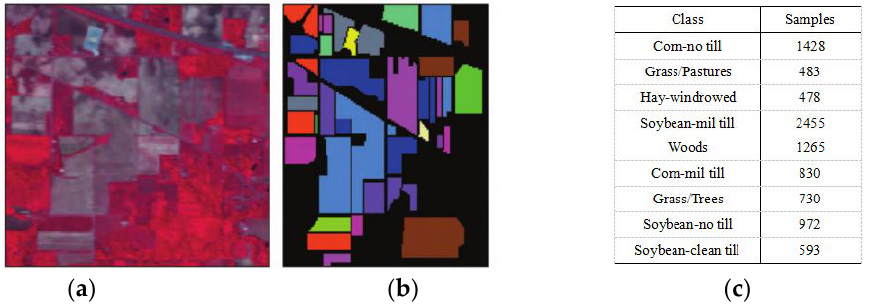
Figure 5. Indian Pines data set ( a ) false color image ( b ) corresponding ground object type ( c ) number of sample sets.